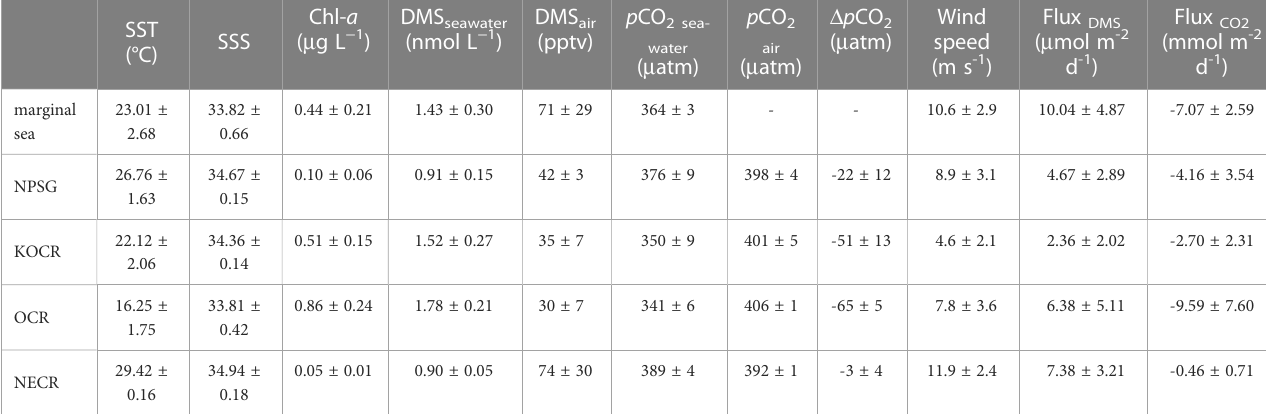
TABLE 1 SST, SSS, DO, Chl- a , DMS seawater, DMS air , p CO 2 seawater , and p CO 2 air levels in different